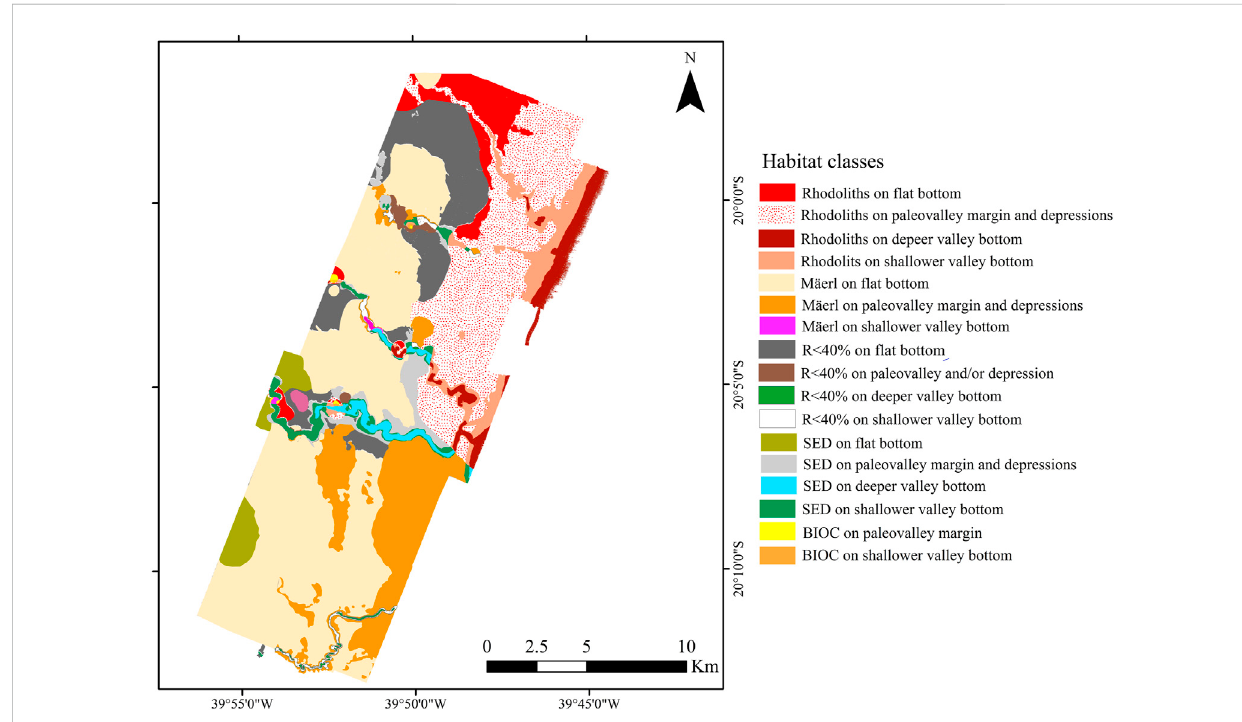
FIGURE 10 Marine habitat map based on the results of the cluster analysis. Habitat classes were de fi ned by clustering data obtained from seabed imagery and geomorphometricanalysis.Bioincrustations(BIOC-rigidbottomwithbenthiccover);Unconsolidatedsediment(SED-unconsolidated fi neandcoarseR > sediments); Rhodoliths (40%- > 40% of the frame covered by rhodoliths).